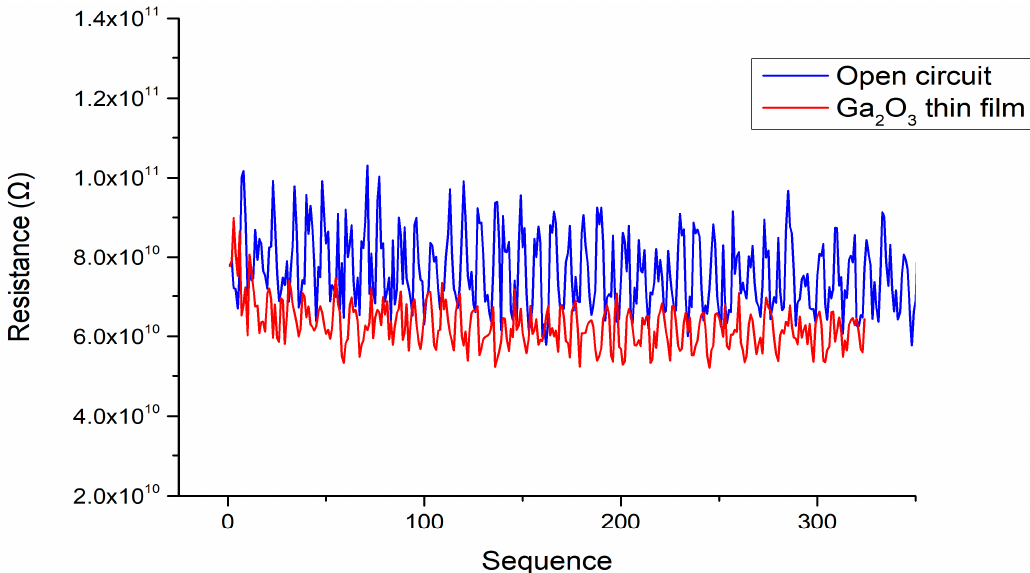
Figure 10. Comparison of the sequence (in continuous loop mode) high-resistance measurement results between the Ga 2 O 3 thin film and open circuit.